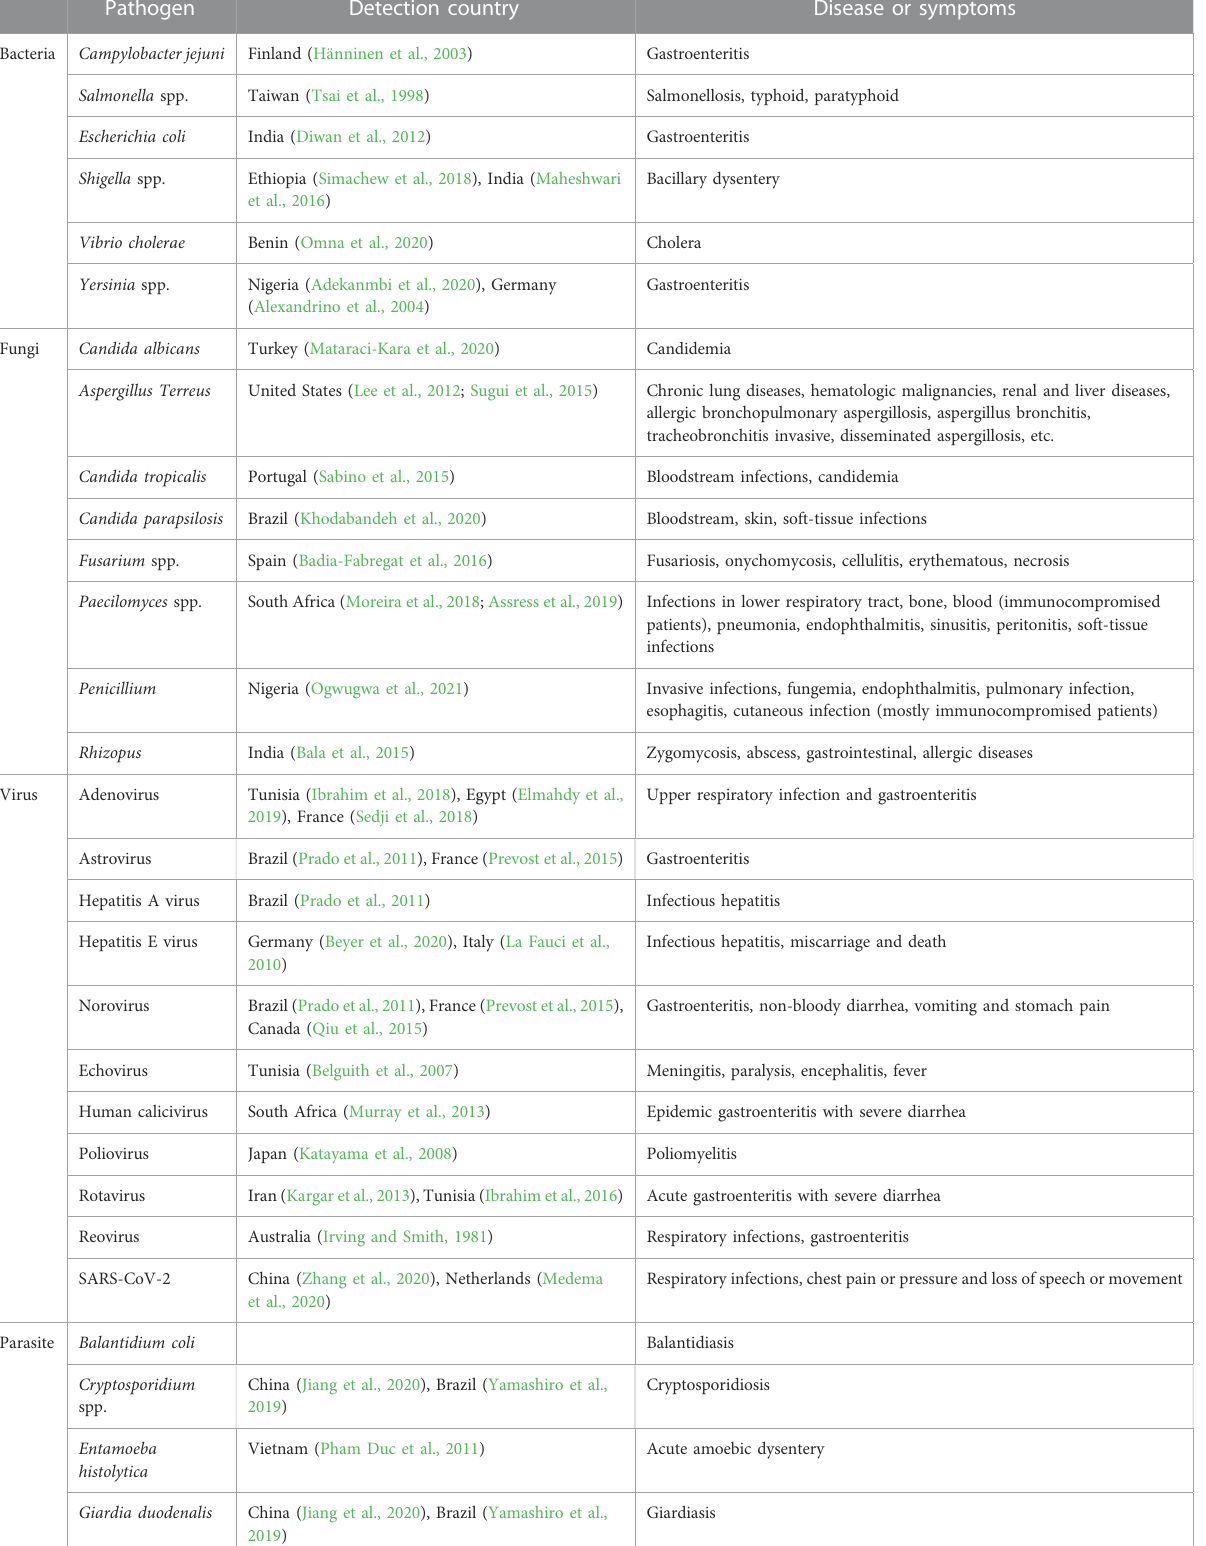
TABLE 1 Major pathogens of health concern in wastewater and related